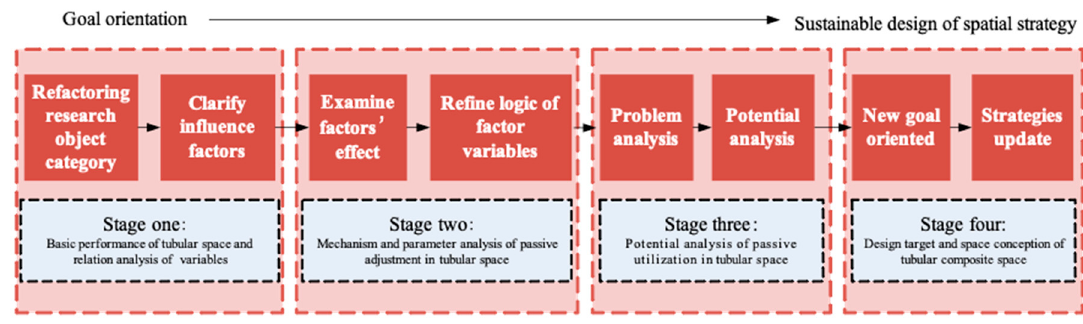
Figure 2. Research methodology route.